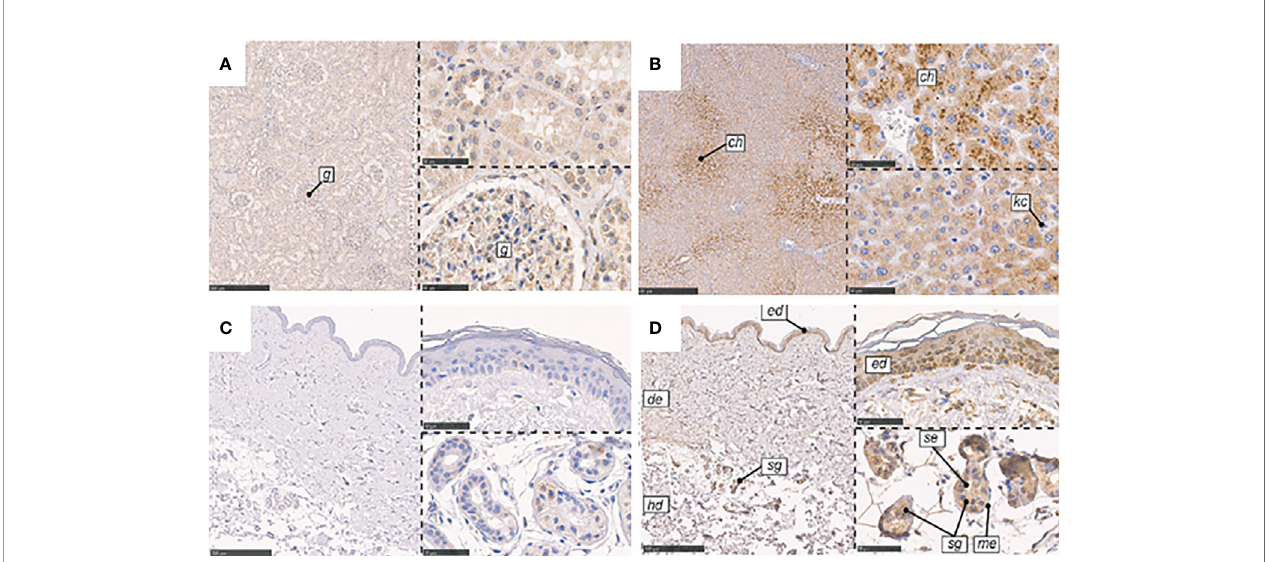
FIGURE 6 | Immunohistochemical localization of CL-K1 and CL-L1 in formalin- fi xed and paraf fi n-embedded sections of kidney, liver, and skin. (A) CL-K1 in the kidney. (B) CL-L1 in the liver. (C) CL-K1 in the skin. (D) CL-L1 in the skin. Italic letters within the images refer to: 1) h: hepatocytes, ch: centrilobular hepatocytes, and kc: Kupffer cells for the liver; 2) g: glomerulus for the kidney; and 3) ed: epidermis, de: dermis, hd: hypodermis, sg: sweat glands, me: myoepithelial cells, and se: strati fi ed cuboidal epithelia cells for the skin. This fi gure is modi fi ed and reprinted from Hansen, et al. in 2018 (36). Scale bars in large sections correspond to 500 m m and in small sections to 50 m